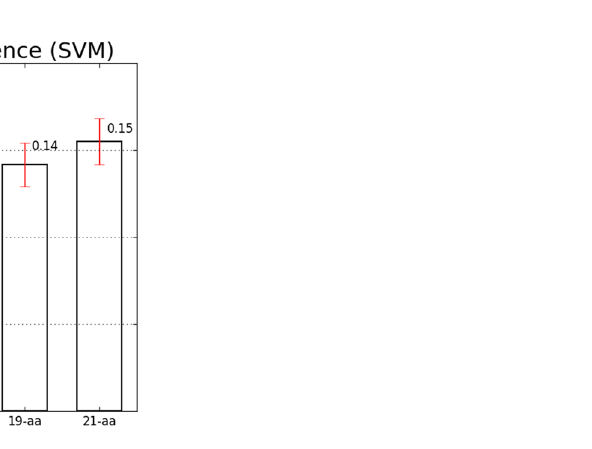
Figure 2. Prediction performance of SIRT1 substrates with different sequence lengths based on SVM. Error bar charts containing mean value and standard error were utilized here to visualise MCC results.